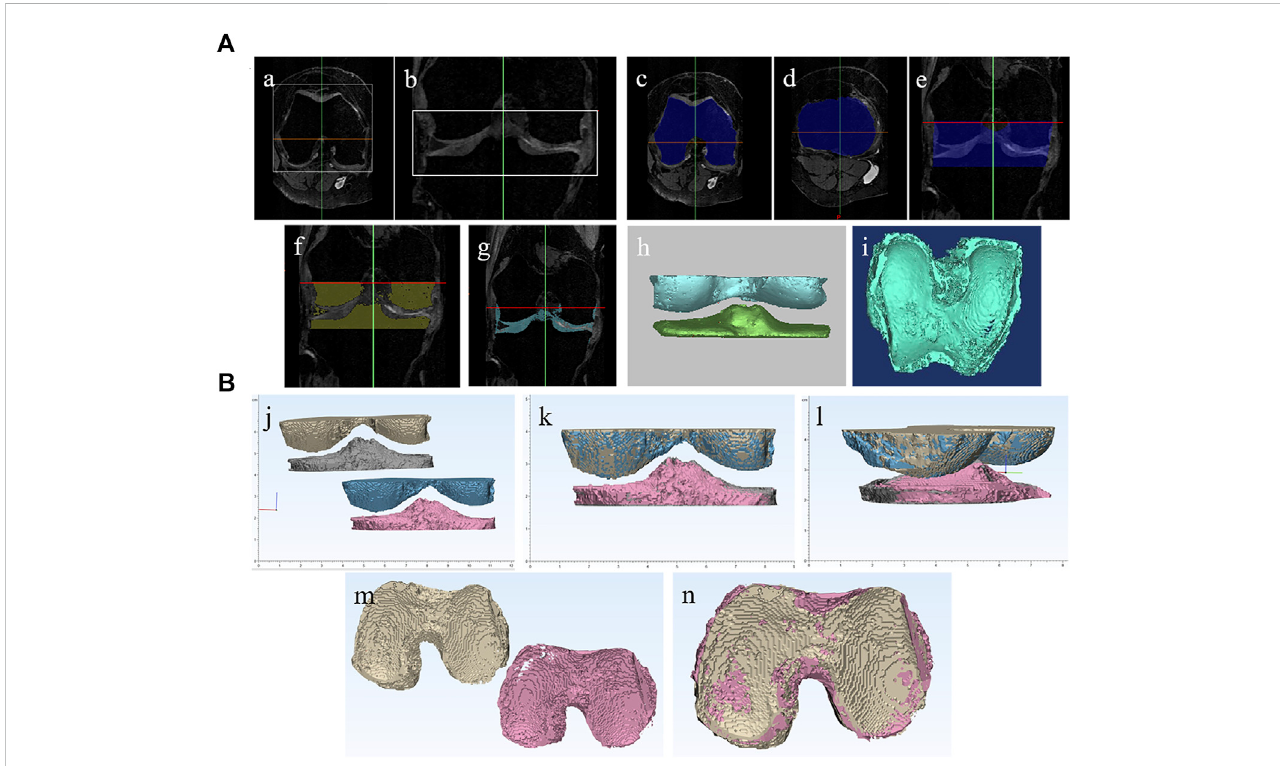
FIGURE 1 Establishment of human knee joint MRI 3D models and 3D spatial alignment method. (A) Establishment of human knee joint MRI 3D models: (a,b) The detectionrangefromthefemoralcondyletothetibialplateauofkneejointisselectedincoronalplaneandsagittalplaneofMRI; (c – e) regiongrowingmethod is used to obtain thecontour curves of all planesof thedetection range; (f,g) Based on the gray scale thresholds of cartilage or bone, the scanning sequences ofcartilage orbonewithin theselected regionare identi fi edrespectively. (h,i) thecartilageandbone3DMRImodelsare generated. (B) .Establishmentof 3D spatial alignment method: (j-n) 3-matic was applied to spatially align the MRI image data I and II based on osteogenic section to ensure that the cartilage section is registered in the same 3D spatial